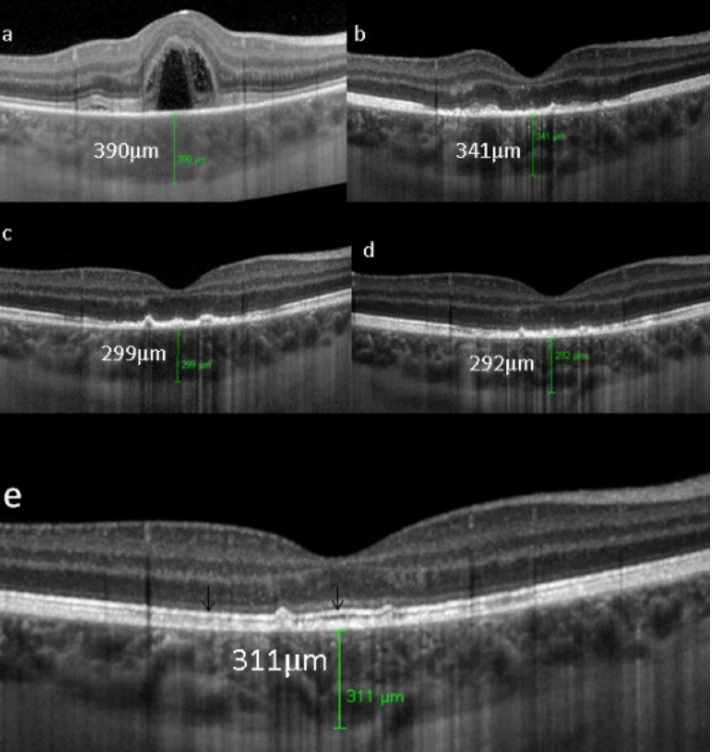
Figure 34. UAIM. EDI-OCT findings from one day after symptom onset to one year later. ( a ) at presentation, a neurosensory dome-shaped foveal (bacillary layer) detachment with compartmental- ized subretinal turbid fluid and a choroidal thickening beneath the fovea. ( b ) a week later, complete resolution of the foveal detachment, damage of the outer retina with the loss of the ellipsoid zone and reduction of the choroidal thickness. ( c ) three weeks later, the outer retinal boundary is less irregular and the choroidal thickness is reduced. ( d ) two months later, further reorganization of outer retinal structures without the visualization of the ellipsoid zone. ( e ) one year later, there is an almost complete normalization of the outer retina with the recovery of the ellipsoid zone and interdigitation zone (black arrows). The choroidal thickness (green cursor) remains low compared to onset of the